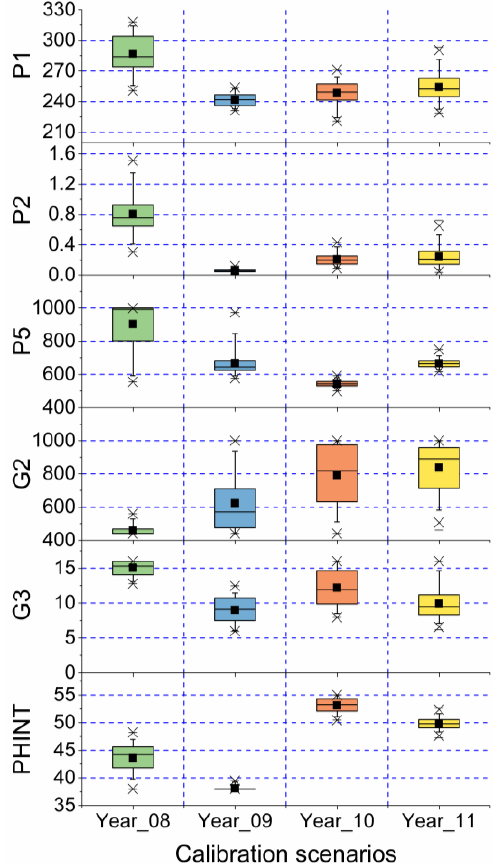
Figure 2. Variability in optimized maize cultivar parameters (P1, P2, P5, G2, G3, and PHINT as defined in Table 1) among the selected cases with Φ (objective function) values within 10% of calibrated minimum Φ values from the 300 cases generated by Latin hypercube sampling (LHS) for each Calibration-by-Year scenario. The boxplots show the minimum and maximum values (asterisks), medians (lines), and means (dots). The 25% and 75% percentiles are shown as the tops and bottoms of the boxes, and the 5% and 95% percentiles are shown as the whiskers below and above the boxes.